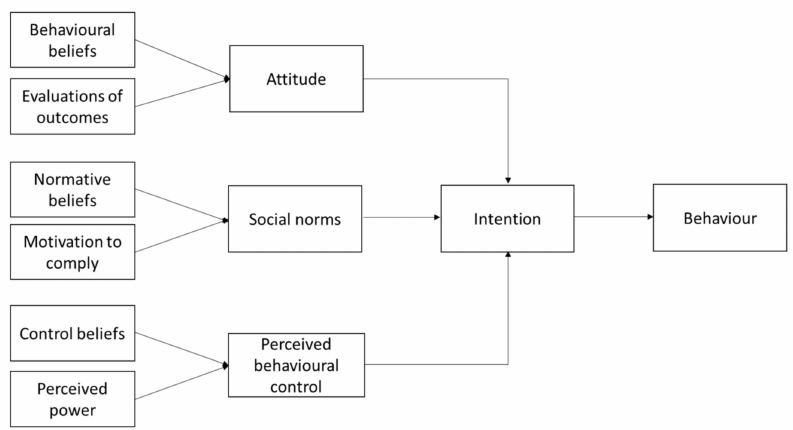
Figure 1. The reasoned action approach. The figure was drawn by authors following the model described in the text.